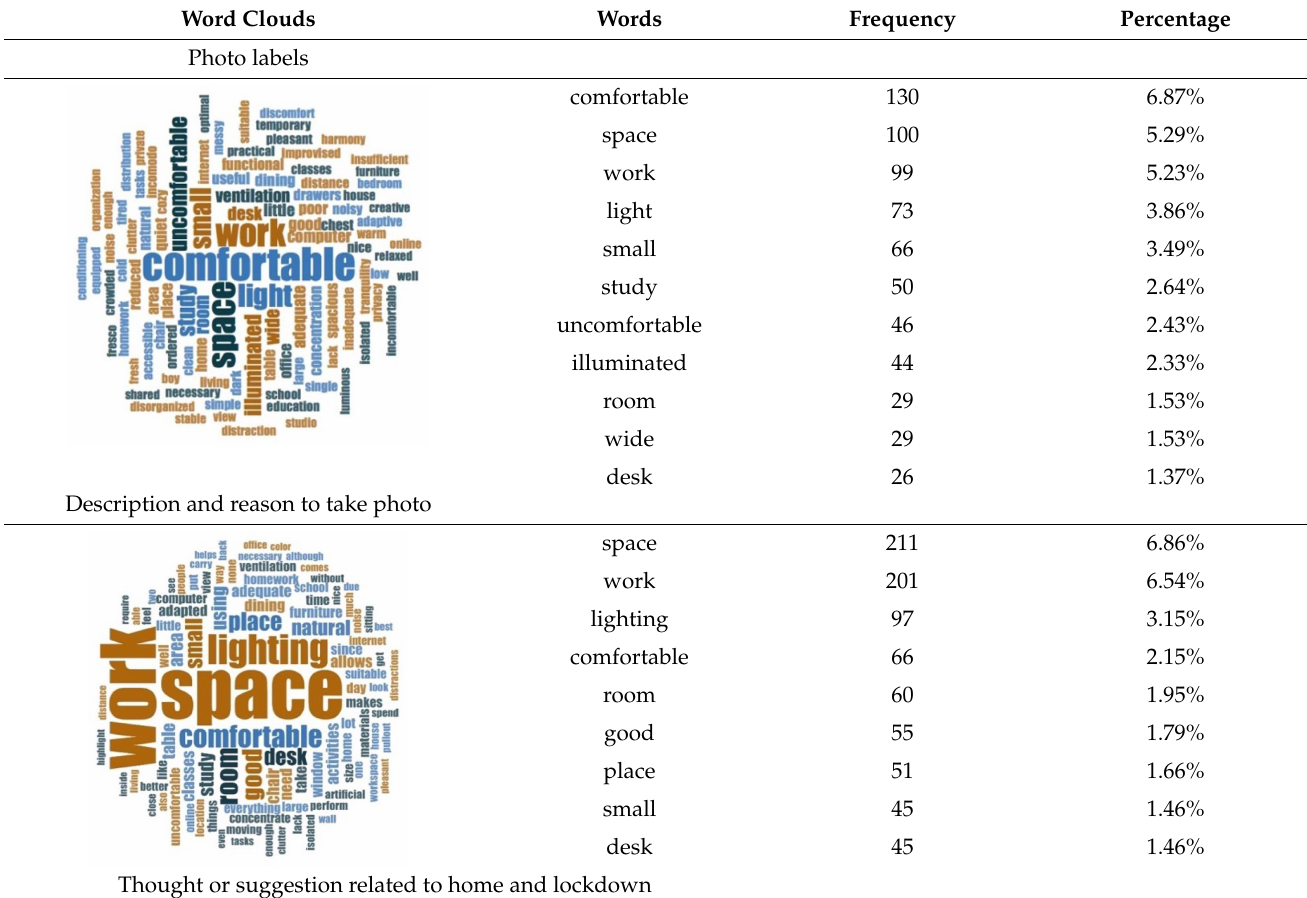
Table 6. Frequency and word clouds of total tags and descriptive responses and reflections or suggestions of photos made about the participants’ workspace or